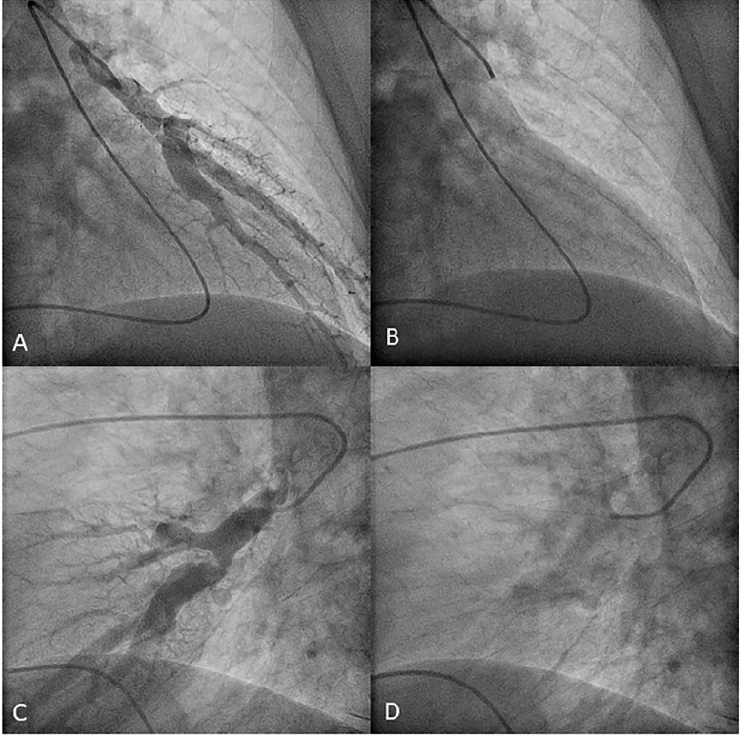
Figure 24. JL catheter position canulating the left upper lobe anterior segmental branch (A3), ( B , D ) with and ( A , C ) without contrast. Figure 25. JL catheter position canulating the lingula artery, with ( A , C ) and without ( B , D ) con- trast.